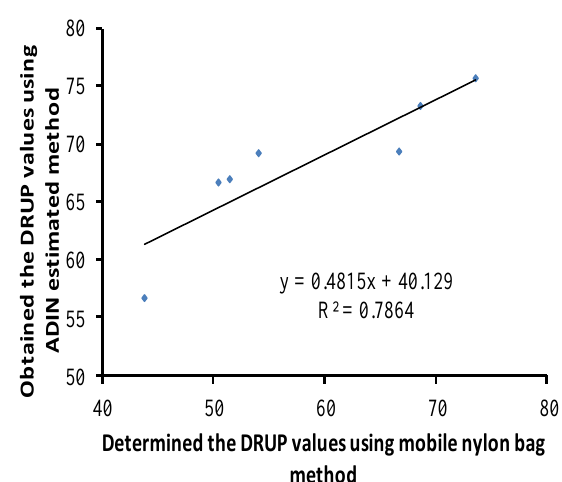
Figure 8. Predicted analysis between MNB observed values and ADIN estimated value in the roughages. DRUP, digestibility of rumen undegradable protein; MNB, mobile nylon bag method; ADIN, acid detergent insoluble nitrogen